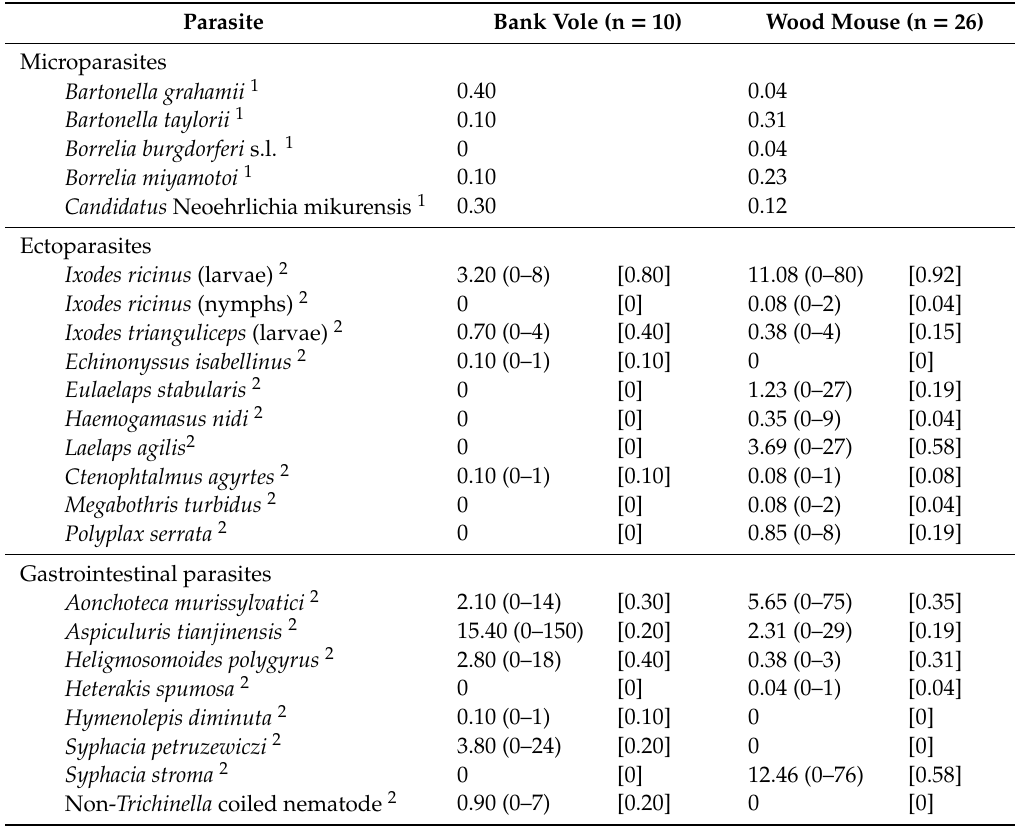
Table 1. Overview of infection with vector-borne microparasites and infestation with ecto- and gastrointestinal parasites in wood mice and bank voles in four Dutch forest